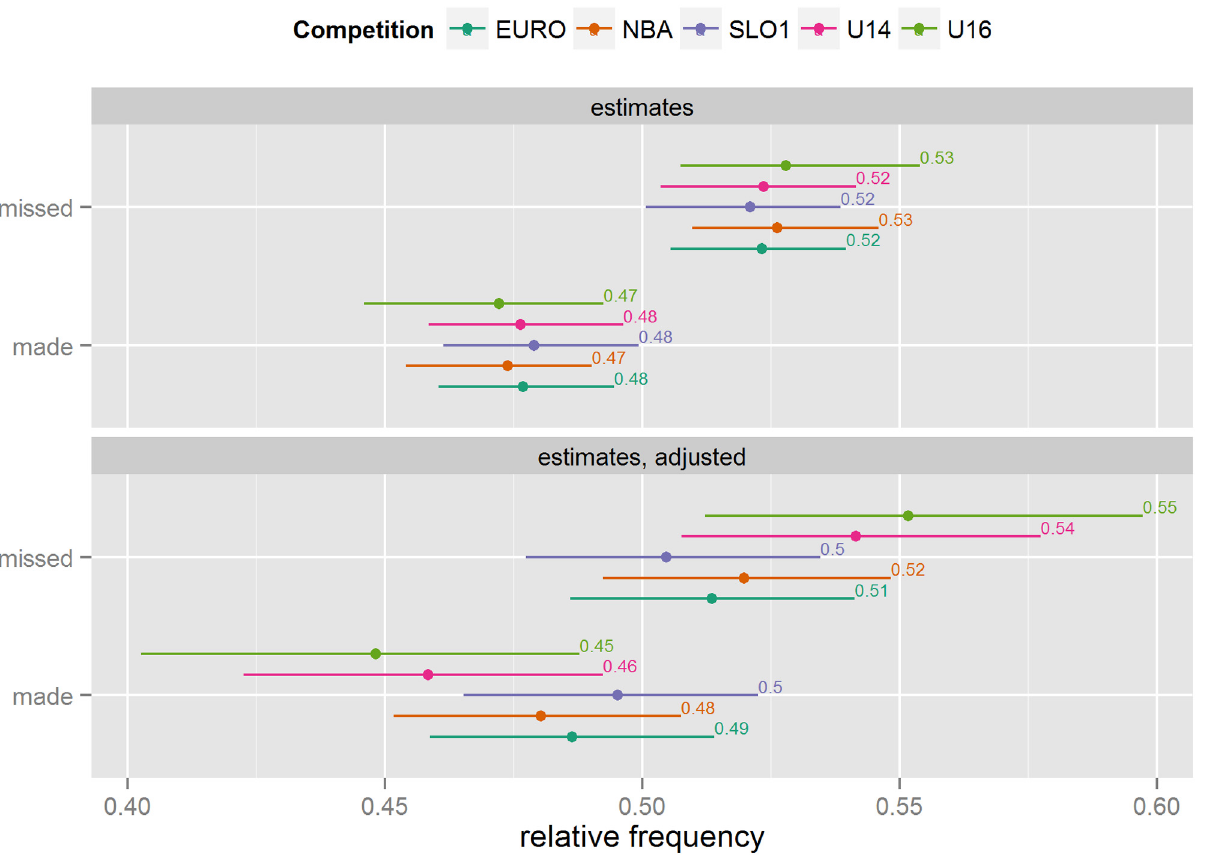
Fig 5. Shot success frequency estimates (unadjusted and adjusted for differences in situational variables).